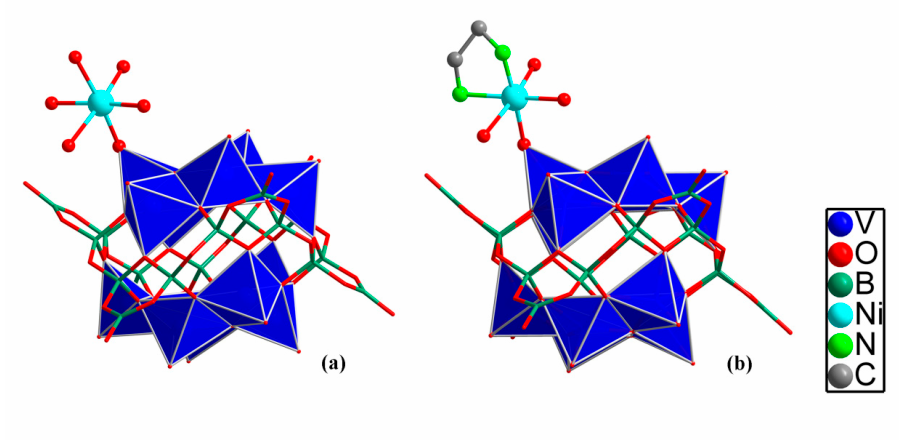
Figure 5. The [V 12 B 18 O 60 ] core bonded to: ( a ) Ni(H 2 O) 52+ in ( 28 ) and ( b ) [Ni(H 2 O) 3 (en)] 2+ in ( 29